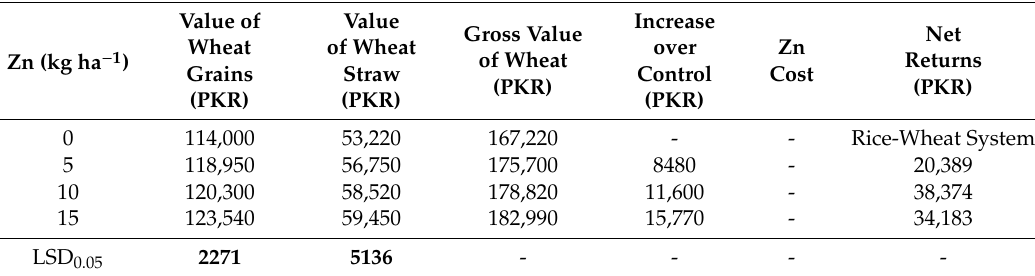
Table 5. Impact of residual soil zinc on the economic analysis of the subsequent wheat crop under rice–wheat cropping